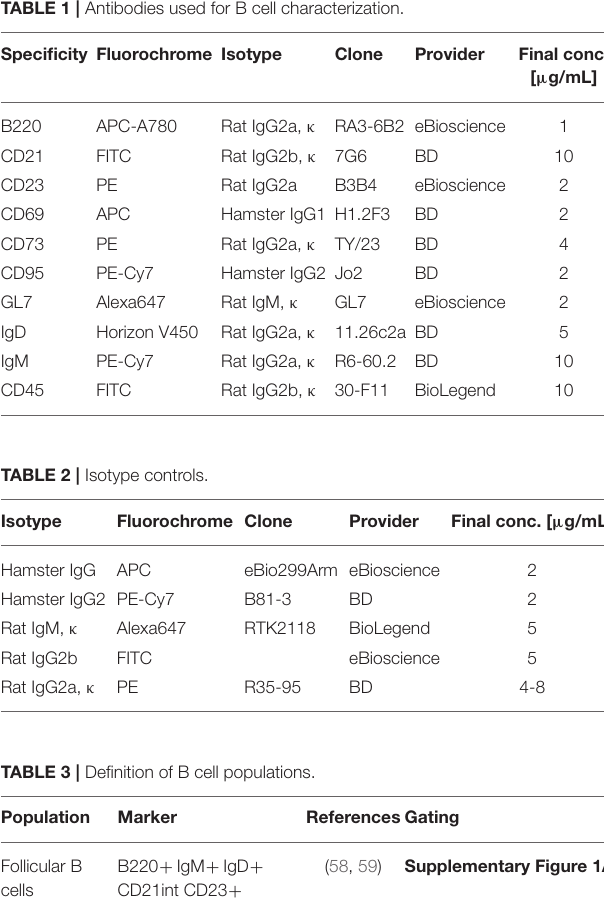
TABLE 1 | Antibodies used for B cell